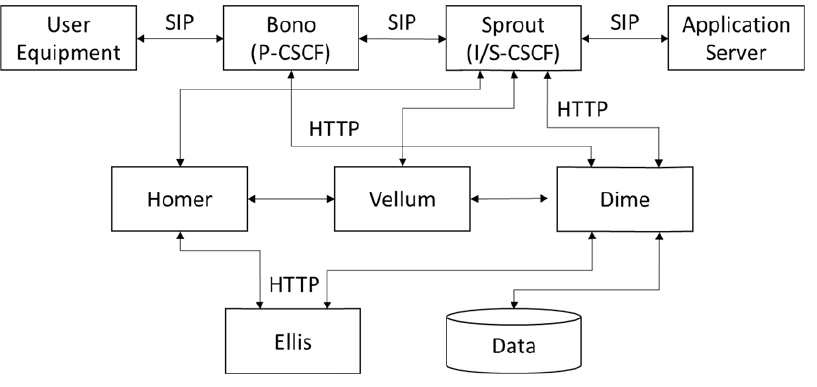
Figure 7. Packet path in PVVP scenario.